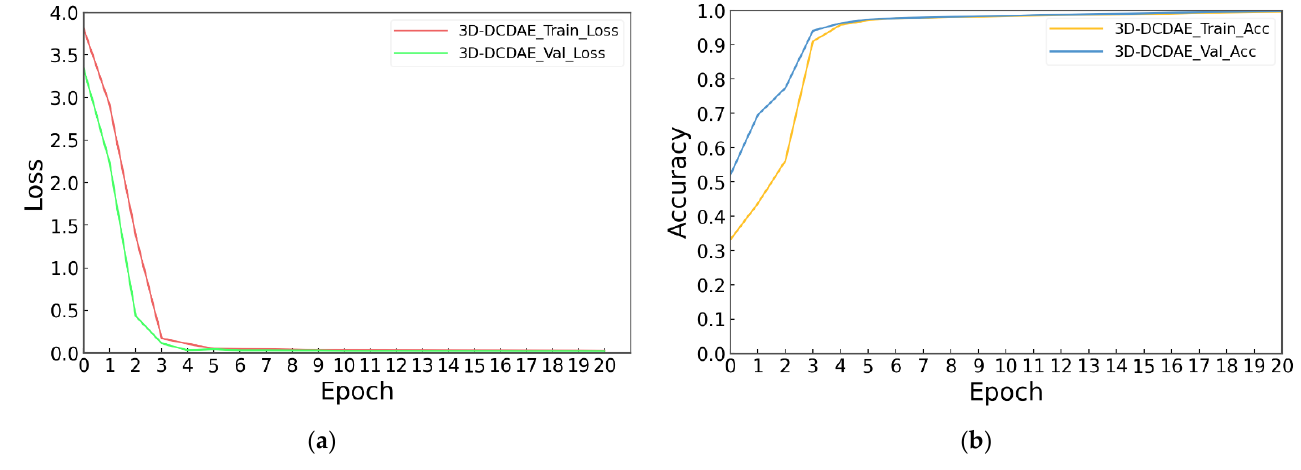
Figure 6. ( a ) The loss of 3D-DCDAE. ( b ) The accuracy of 3D-DCDAE.